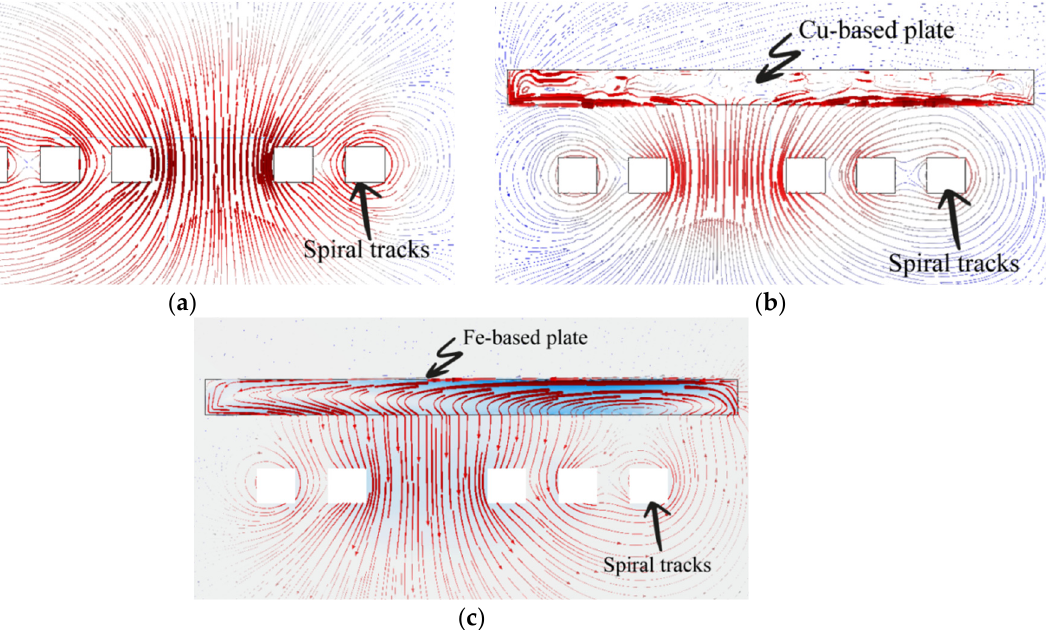
Figure 3. Module and direction distribution of the tangential magnetic field (thicker lines reflect higher intensity): ( a ) without shielding, ( b ) with Cu-based shielding, and ( c ) with Fe-based shielding.